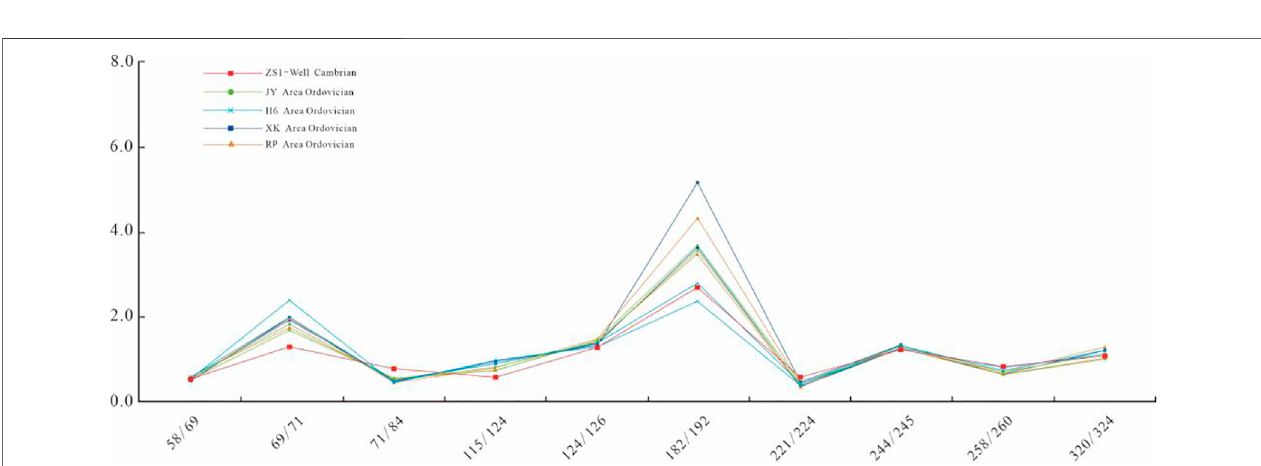
FIGURE7| ComparisonofmediummolecularweighthydrocarbonsinthecrudeoilfromwellZhongshen1totheHalahatangArea.Note(58:n-propylcyclohexane; 69: 2-methylnonane (C 10 isoalkane); 71: 3-methylnonane (C 10 transisoalkane); 84: 2,6 dimethyl Nonane (C 11 isoalkane); 115: n-pentylcyclohexane + 1-methyldecanes; 124: 2-methylundecane (C 12 isoalkane); 126: 3-methylundecane (C 12 transisoalkane); 150: 4-methyldodecane; 153: 3-methyldodecane (C 13 transisoalkane); 182: 2,6,10-trimethyldodecane; 192: Decane with C 5 as a substituent; 221 (n-decylcyclohexane + 7-methylpentadecane + 6-methylpentadecane); 224: 2- methylpentadecane (C 16 isoalkane); 258: n-undecylcyclohexane+5-methylheptadecane; 260: 2-methylheptadecane (C 18 isoalkane); 309: 2-methyleicosane (C 21 isoalkane); 311 : 2,6,10,14-tetramethylnonadecane).